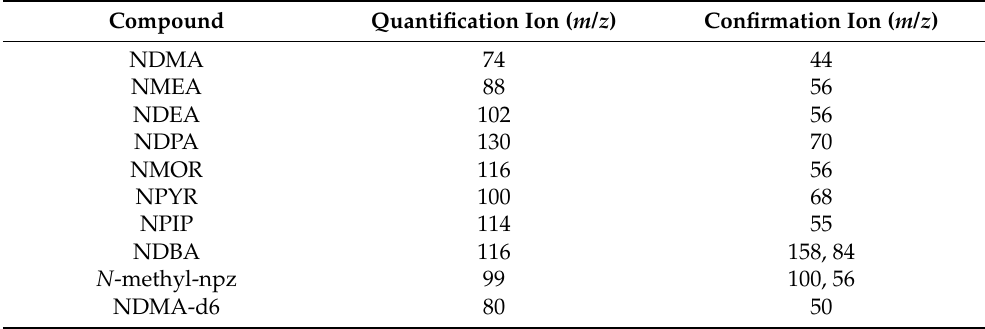
Table 5. GC-MS SIM for the detected